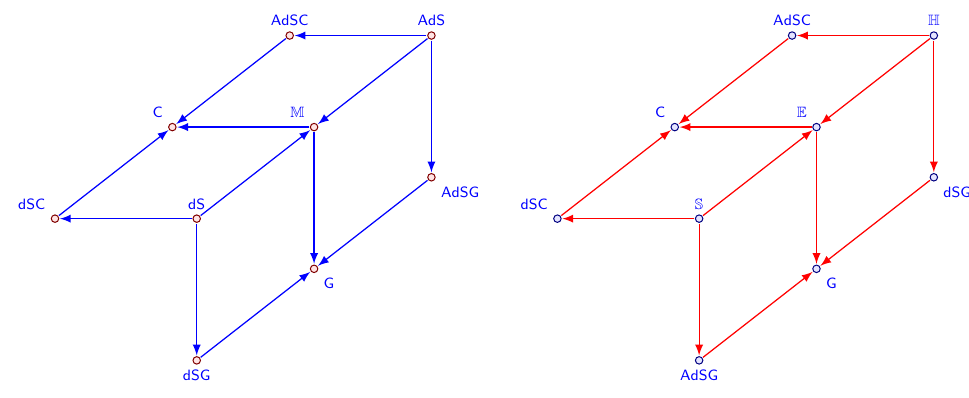
Figure 2 . Maximally symmetric spaces and their limits: non-relativistic (vertical), ultra-relativistic (horizontal) and (cid:13)at